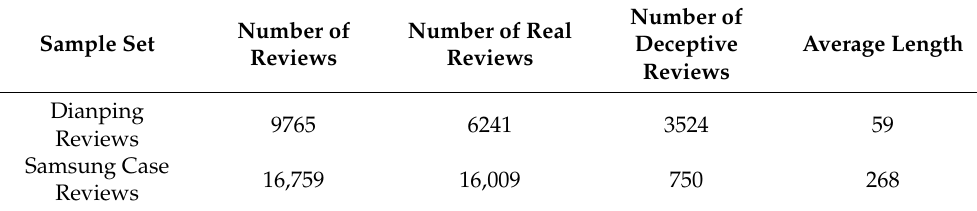
Table 1. Number of real and false reviews according to the sample